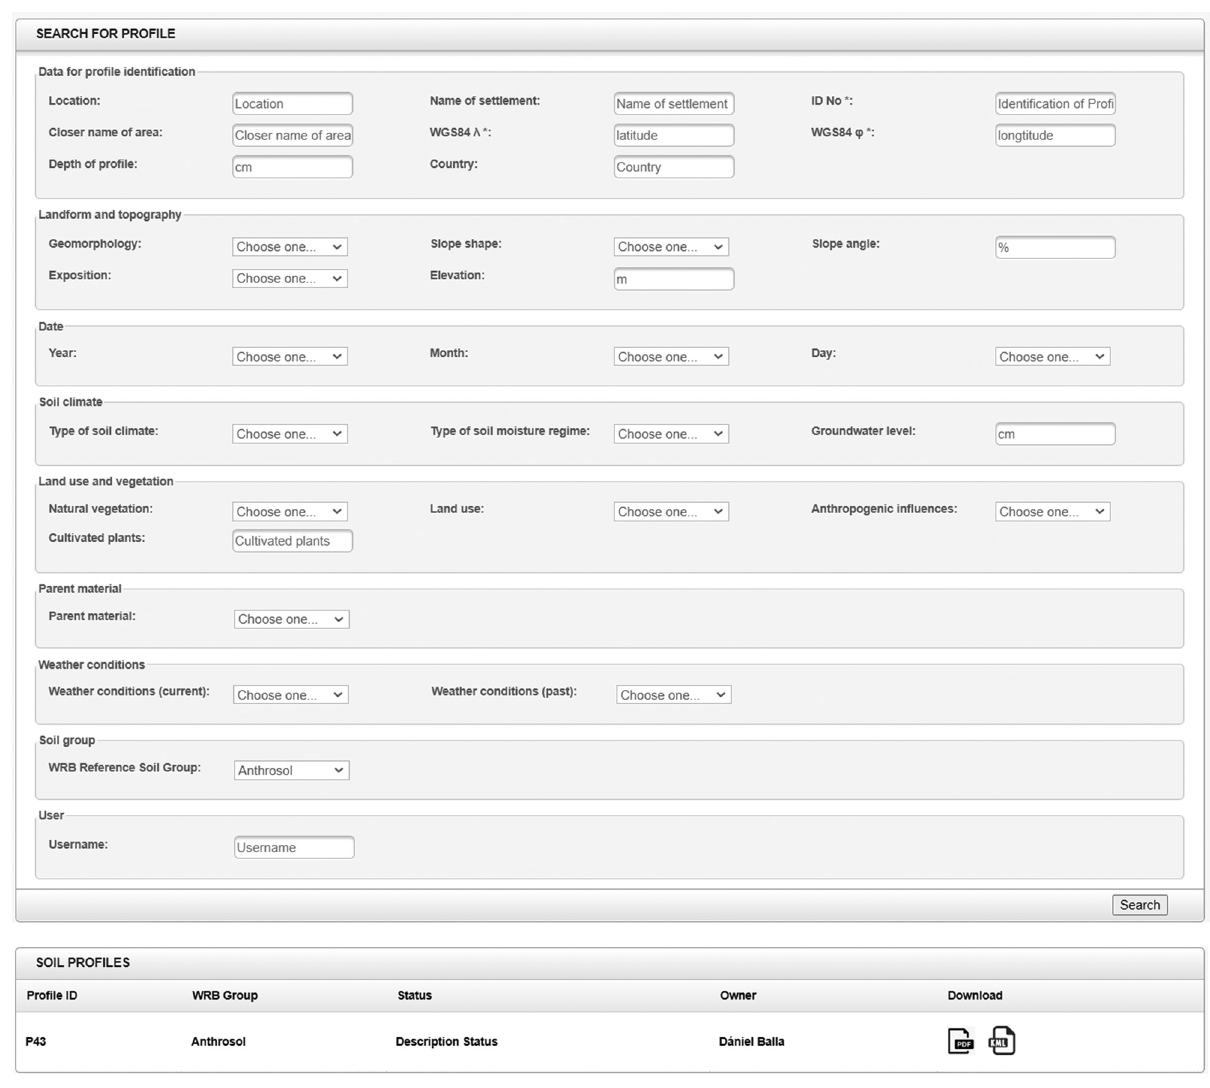
Figure 10: Result of query interface after